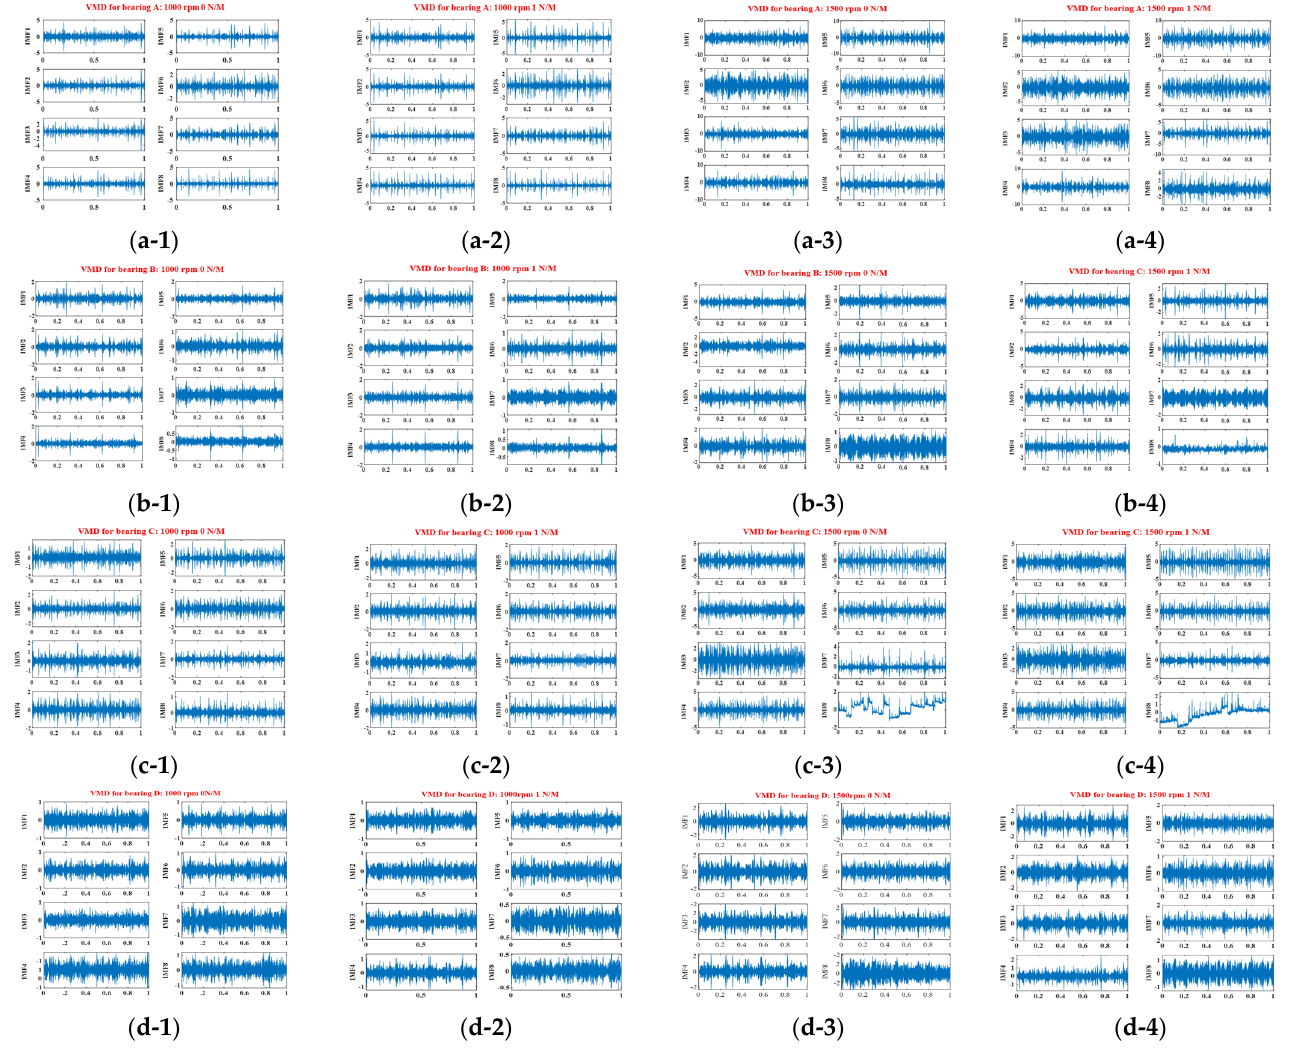
Figure 4. VMD decomposition signals under different working conditions. Bearing ( a – d ) represent little fault, medium fault, high fault, and fault-free, respectively. ( a ) 1 represents the torque of the load motor is set at 0 N/m under 1000 r/min. ( b ) 2 represents the torque of the load motor is set at 1 N/m under 1000 r/min. ( c ) 3 represents the torque of the load motor is set at 0 N/m under 1500 r/min. ( d ) 5 represents the torque of the load motor is set at 1 N/m under 1500 r/min.